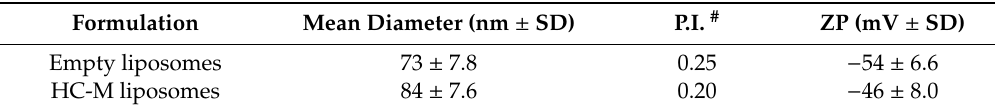
Table 4. Characteristics of empty liposomes and H. crepitans extract (HC-M) loaded liposomes: intensity-weighted mean hydrodynamic diameter, polydispersity index (P.I.), and zeta potential (ZP). Each value represents the mean ± SD, n > 10; # SD for P.I. values was always < 0.03. Formulation Mean Diameter (nm ±